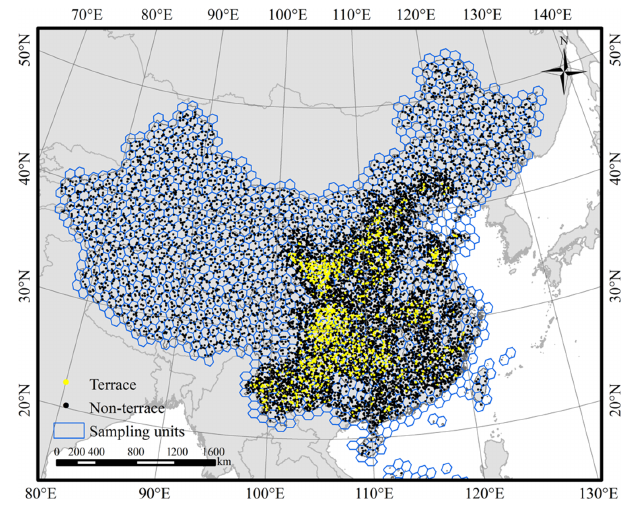
Figure 2. The spatial distribution of the test